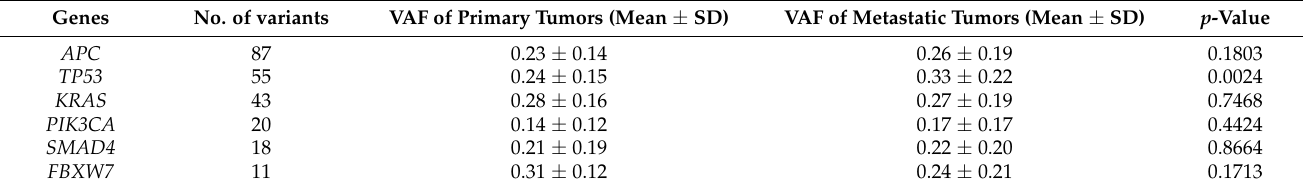
Table 2. Variant allele frequency (VAF) of frequently mutated top six genes between primary and metastatic CRCs. Genes No. of variants VAF of Primary Tumors (Mean ± SD) VAF of Metastatic Tumors (Mean ± SD) p -Value APC